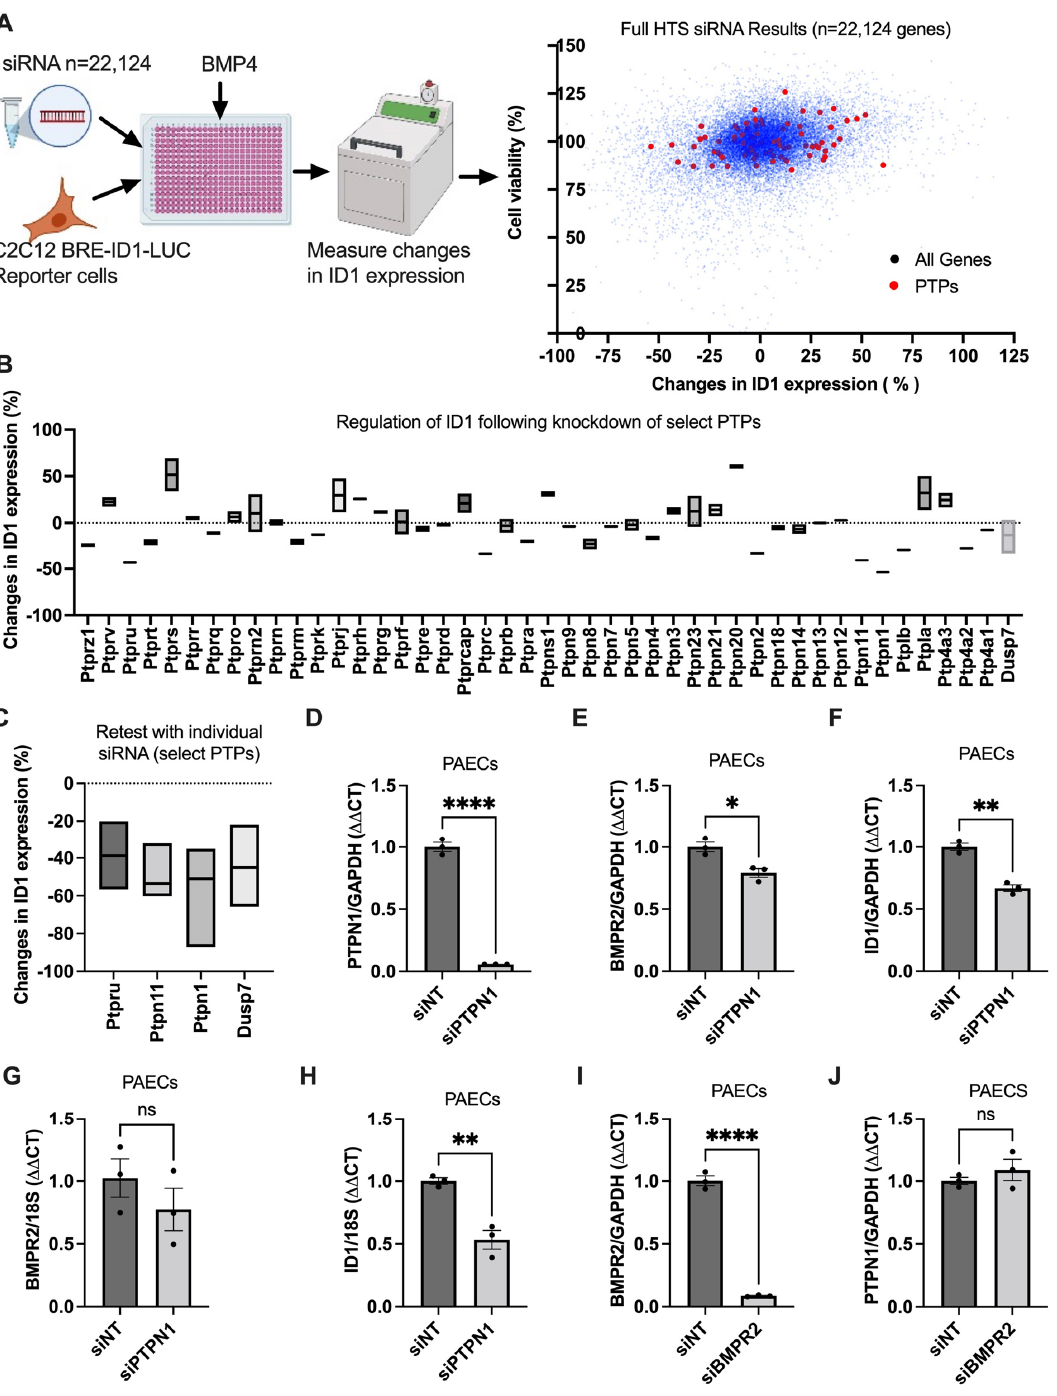
Figure 1. PTPN1 is a novel regulator of BMPR2 signaling pathway. A siRNA-mediated HTS ( n = 22,124) was performed to identify possible BMPR2 signaling modifiers in mouse myoblastoma BRE-ID1-LUC incorporated reporter cells. After 48 h knockdown of the genes, cells were treated with BMP4 to activate the signaling for two hours and then measured for ID1-linked luciferase levels. A colorimetric trypan blue cell viability was also performed. ( A ) Changes in ID1-linked luciferin ex- pression ( n = 22,124) (X-axis) versus cell viability (Y-axis) were plotted. Red dots denote the pre- selected protein tyrosine kinases (PTPs) selected from all major PTPs. ( B ) Changes in ID1-linked